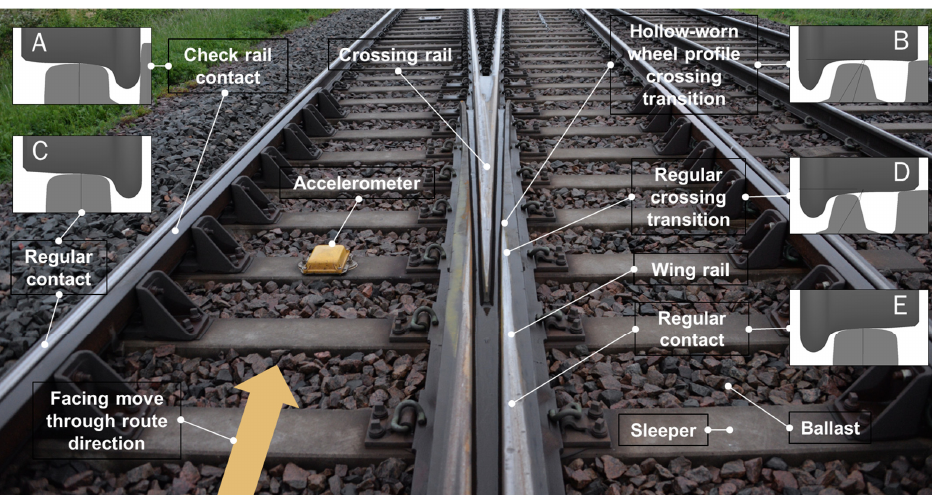
Figure 1. Illustration of a wheelset transition through the crossing panel with the nomenclature for the main components and wheel–rail contact states.